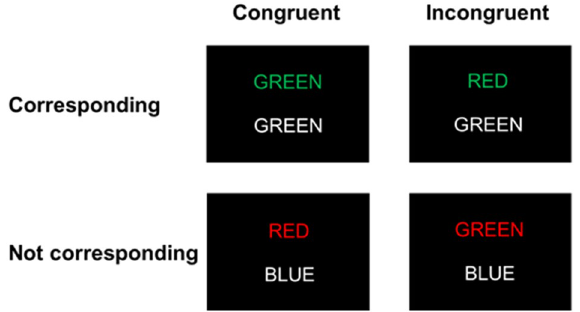
Figure 5. Examples for conditions and design of the color-word matching Stroop task. For the upper two examples, the correct answer would be “YES,” for the lower two examples, the correct answer would be